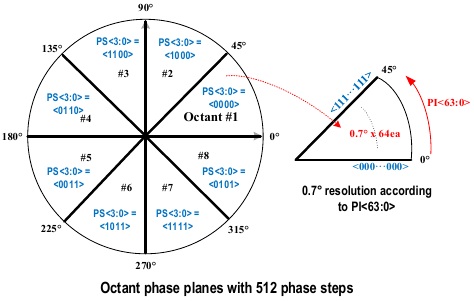
Figure 7. Phase interpolation method of the proposed 9-bit PI with 512 (=2 9 ) steps.